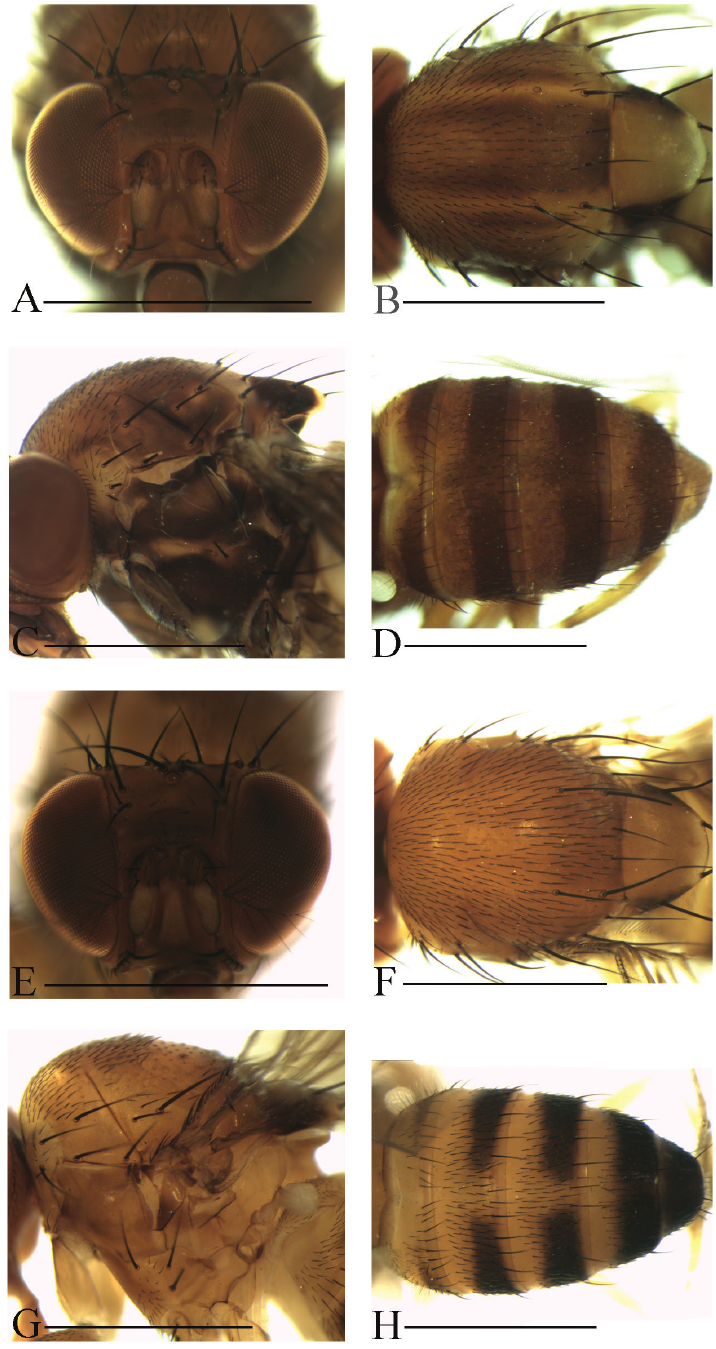
Figure 7. Head, mesonotum, scutellum, pleura and abdomen of male. A–D S. protenipenis sp. n. E–H S . rhina sp. n. Scale bars 1